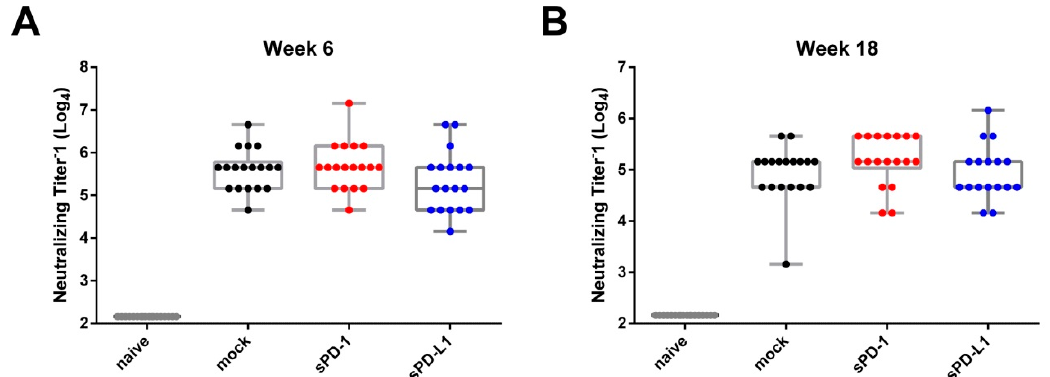
Figure 5. Antibody-mediated neutralization of influenza. Homologous neutralizing titers of vaccine-induced antibodies against influenza A / PR / 8 / 34 shown at week 6 ( A ) and week 18 ( B ). Each dot represents an individual mouse. Shown are whisker plots with median and minimum to maximum distribution ( n = 17–18).